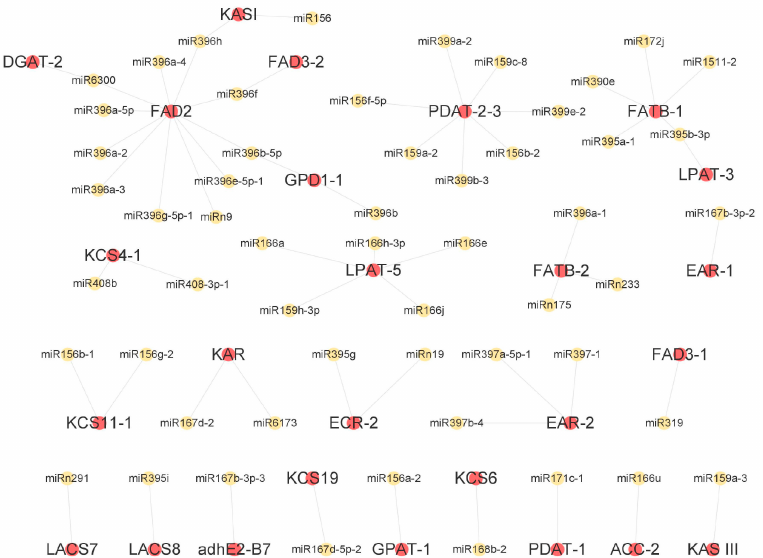
Figure 10. Network of DEM–DEG pairs in the context of FA and TAG biosynthesis pathways. The DEGs are displayed as red circles, and the DEMs are represented by yellow circles.